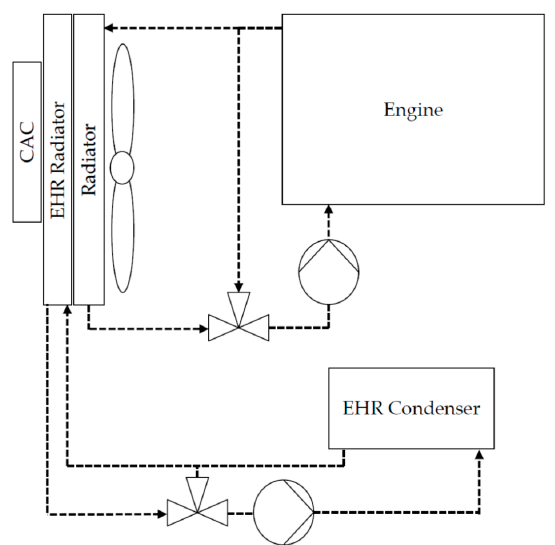
Figure 4. Low temperature cooling system.